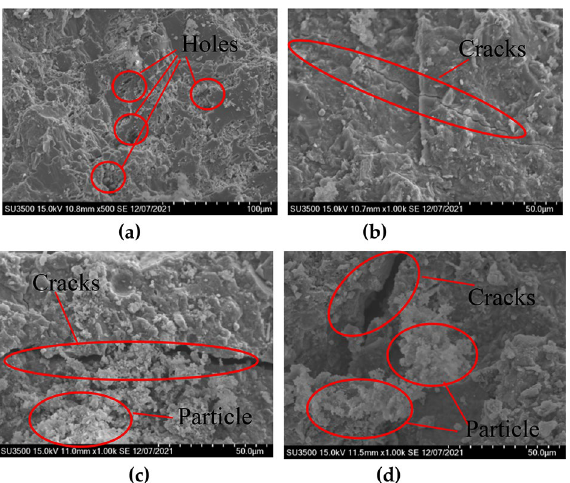
Figure 8. Electron microscope scans of specimen before and after erosion: (a) unconfined concrete of before erosion; (b) after erosio of FRP fully confined; (c) after erosion of FRP semi-confined concrete; (d) after erosion of unconfined